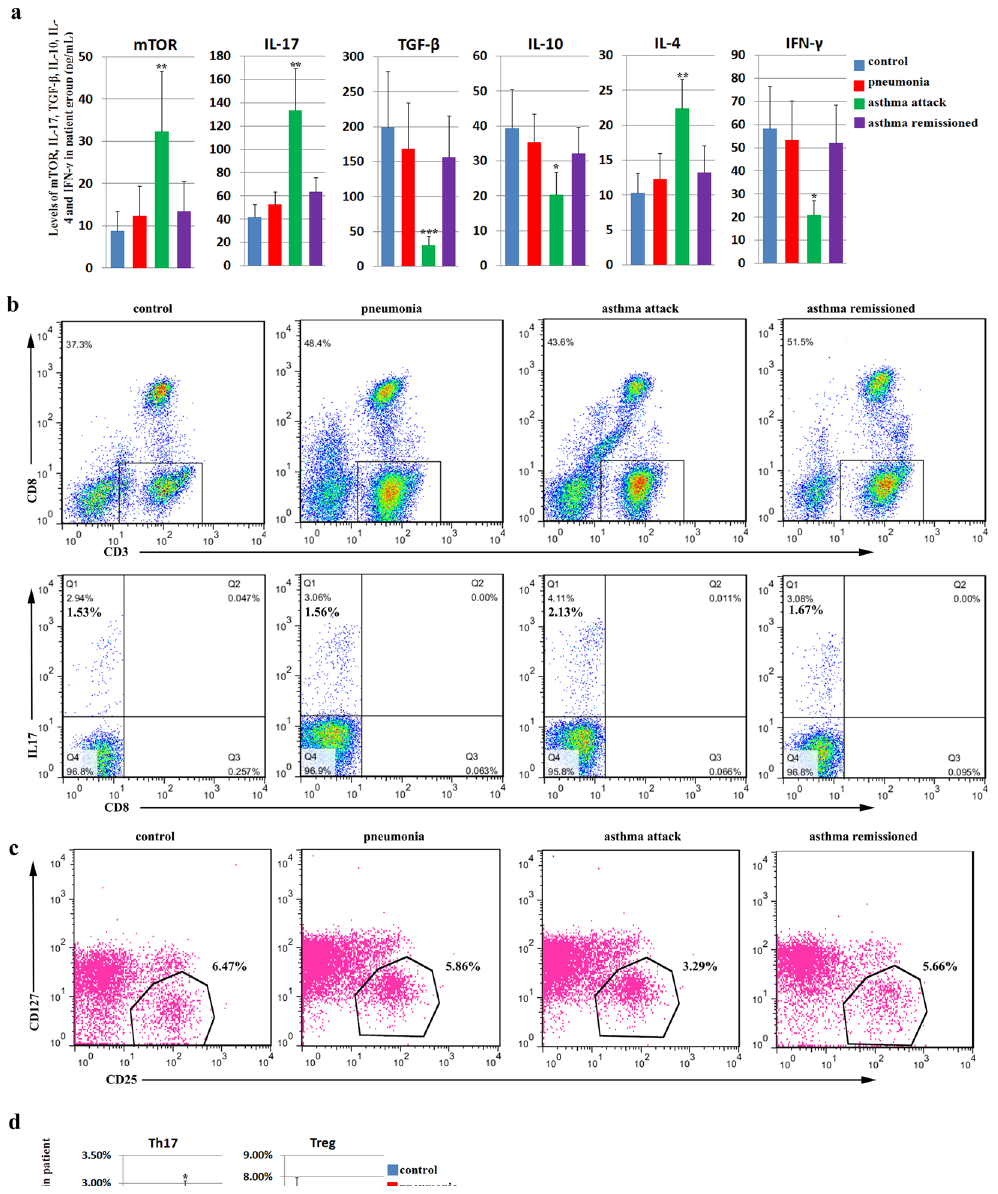
Figure 1. Levels of mTOR, Th17 cells, Treg cells, and asthma-related cytokines in the serum of patients with asthma. The patients were categorized into four groups: the asthma attack group, asthma remission group, community-acquired pneumonia (pneumonia) group, and normal healthy group. The asthma group consisted of children with asthma who visited a doctor or were hospitalized from January 2014 to June 2014. The remission group comprised children who had experienced an asthma attack but were then treated with budenoside and were in asthma remission. The pneumonia group comprised children who were diagnosed with pneumonia in the same hospital in the same period. The healthy control group comprised normal healthy children who had a physical examination in the hospital in the same period. ( a ) The level of serum mTOR (pg/ mL), IL-17 (pg/mL), TGF- β (pg/mL), IL-10 (pg/mL), IL-4 (pg/mL), and IFN- γ (pg/mL) detected by ELISA in the control group, the pneumonia group, the asthma attack group, and the asthma remission group. The levels of mTOR, IL-17, and IL-4 in the serum of patients in the asthma attack group were significantly higher than that in the pneumonia and control groups, whereas these elevations were not observed in patients in asthma. Similarly, the levels of TGF- β , IL-10, and IFN- γ in the serum of patients in the asthma attack group were significantly lower than that in the pneumonia and control groups, whereas reduction of these cytokines was not observed in patients in asthma. ( b ) Flow cytometric analysis of Th17 cells (CD3 + CD8 − IL-17 + ) in peripheral blood mononuclear cells (PBMC) from patients in the control group, the pneumonia group, the asthma attack, and the asthma remission group. The data was presented as the percentage of all live cells. ( c ) Flow cytometric analysis of Treg cells (CD4 + CD25 high + CD127 low ) in PBMC from patients in the control group, the pneumonia group, the asthma attack, and the asthma remission group. ( d ) Levels of Th17 cells (CD3 + CD8 − IL-17 + ) and Treg cells (CD4 + CD25 high + CD127 low ) detected by flow cytometry in PBMC from patients in the control